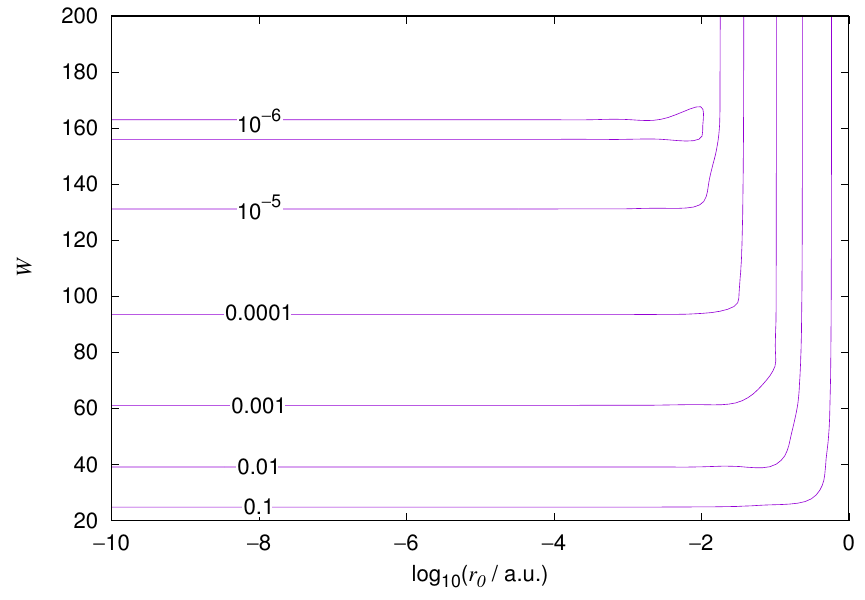
Figure 5. Hydrogen 2p orbital eigenenergy relative error. Notations as in Figure 1.